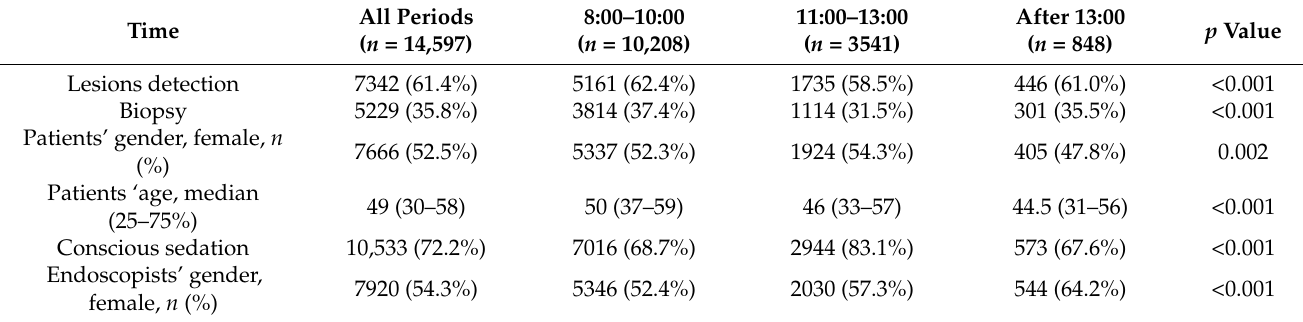
Table 1. Comparison of risk factors and outcomes among three time